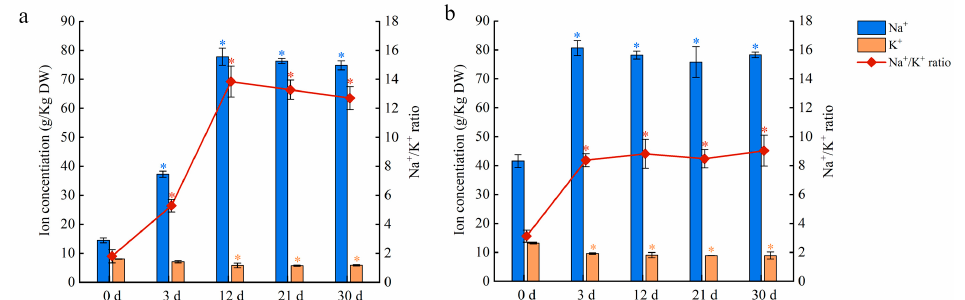
Figure 9. Na and K contents and Na/ K ratio in water lily plants treated with 150 mM NaCl. ( a ) Na content, K content, and Na/ K ratio in leaves. ( b ) Na content, K content, and Na/ K ratio in petioles. Data are the means of three biological replicates ( ± SDs). The asterisks represent statistically significant differences ( p < 0.05).